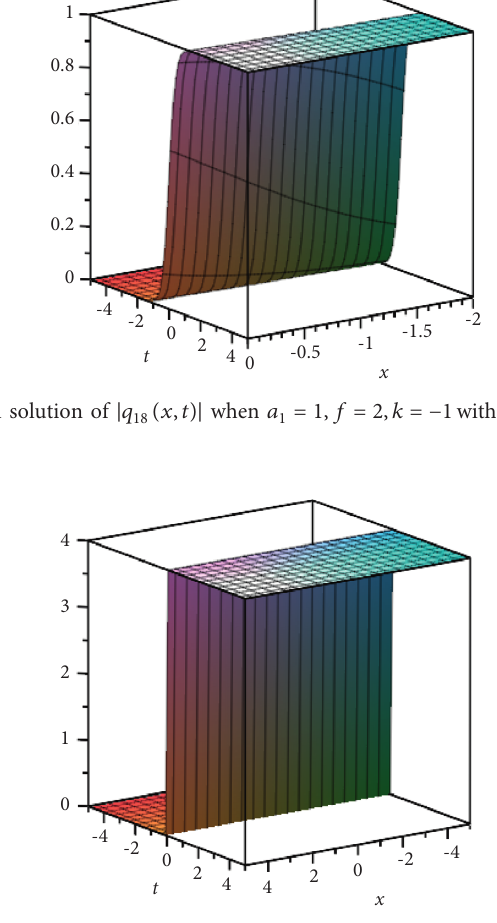
Figure 8: The antikink soliton solution of | q